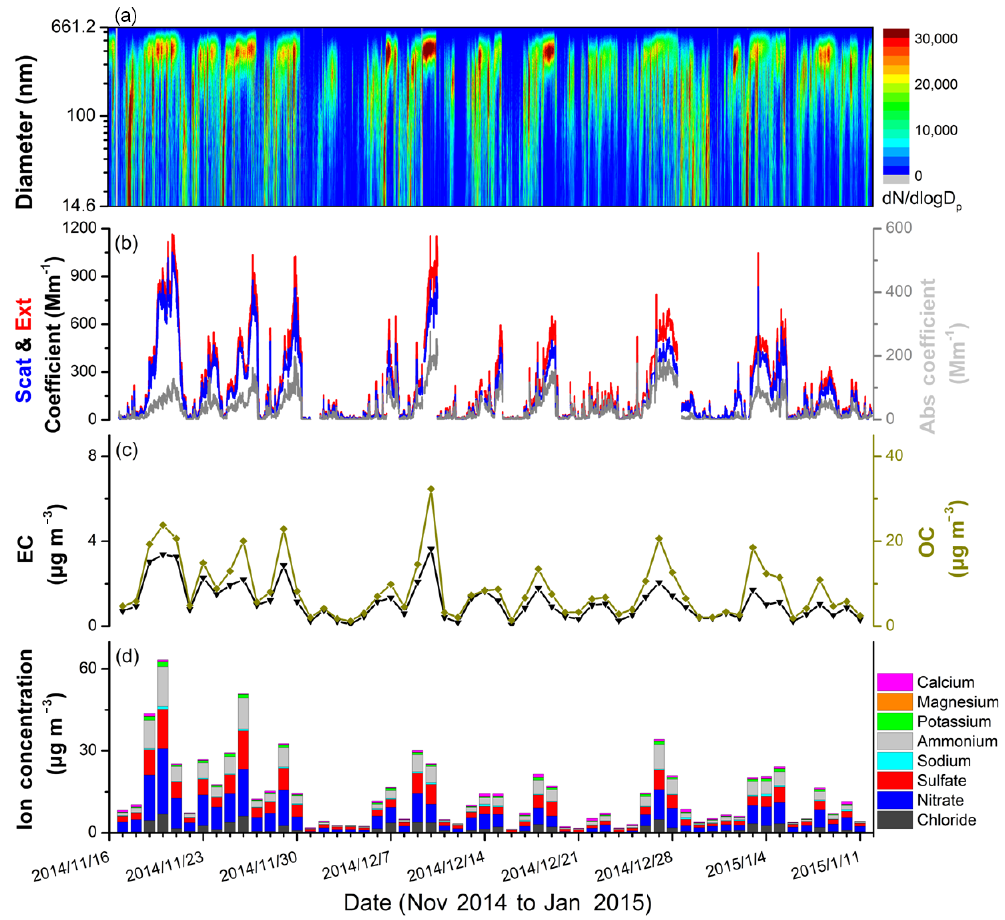
Figure 2. Time series of (a) the aerosol number size distribution measured by SMPS, (b) the extinction, scattering, and absorption coefficients at λ = 470nm measured by cavity-enhanced albedometer, (c) organic carbon and element carbon concentration measured with an offline aerosol carbon analyzer, and (d) water-insoluble ion concentrations measured with an offline ion chromatography of dry PM 1 . 0 particles over the sampling